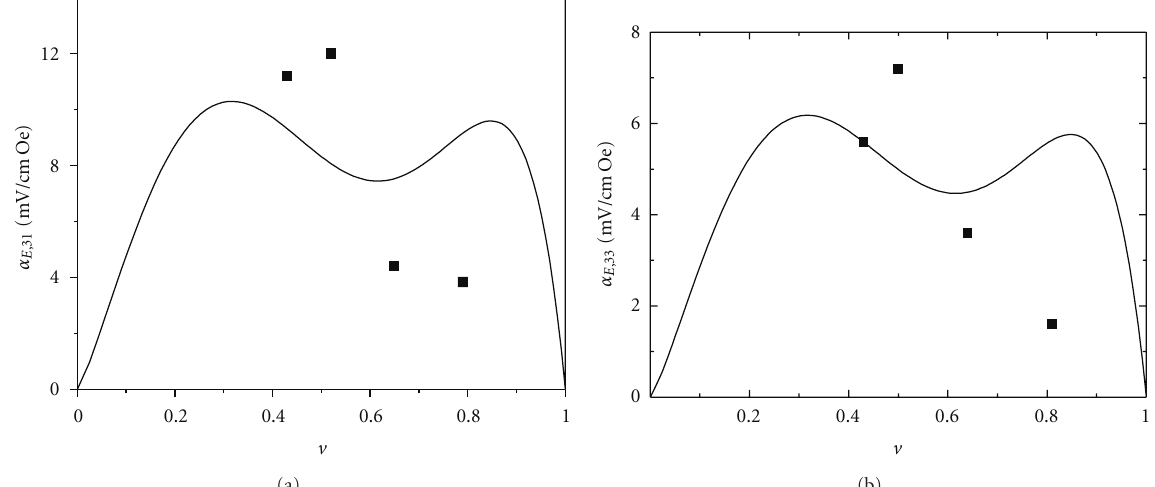
Figure 7: PZT volume fraction dependence of transverse (a) and longitudinal (b) ME voltage coe ffi cients for LSMO-PZT bilayer: solid lines are the theory for k = 0 . 2 and points are